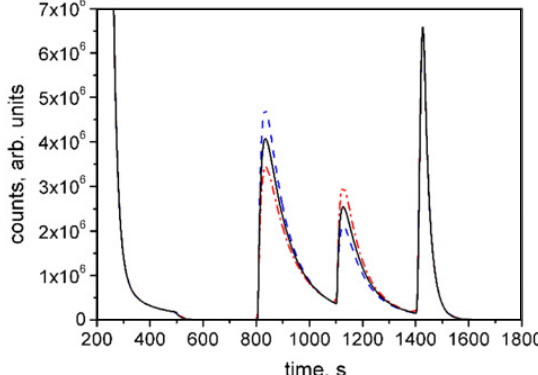
Figure 7. Time diagram for measurements for short holding time without the insert but with monitoring and with the absorber. The angle θ of the first emptying was varied: 14 ◦ (dash-dotted red line), 15 ◦ (solid black line), 16 ◦ (dashed blue